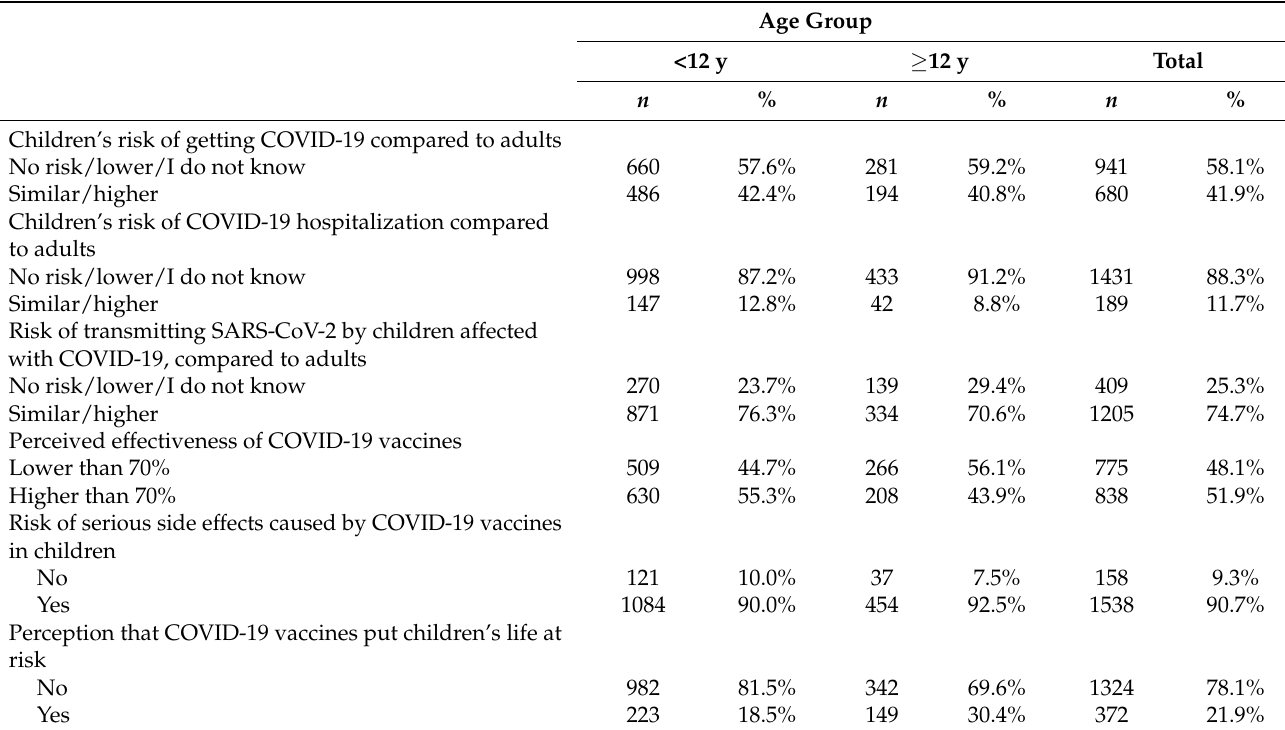
Figure 1. Intention to vaccinate children by target age group. Table 2. Perception of COVID-19 and COVID-19 vaccination in children, by target age group.